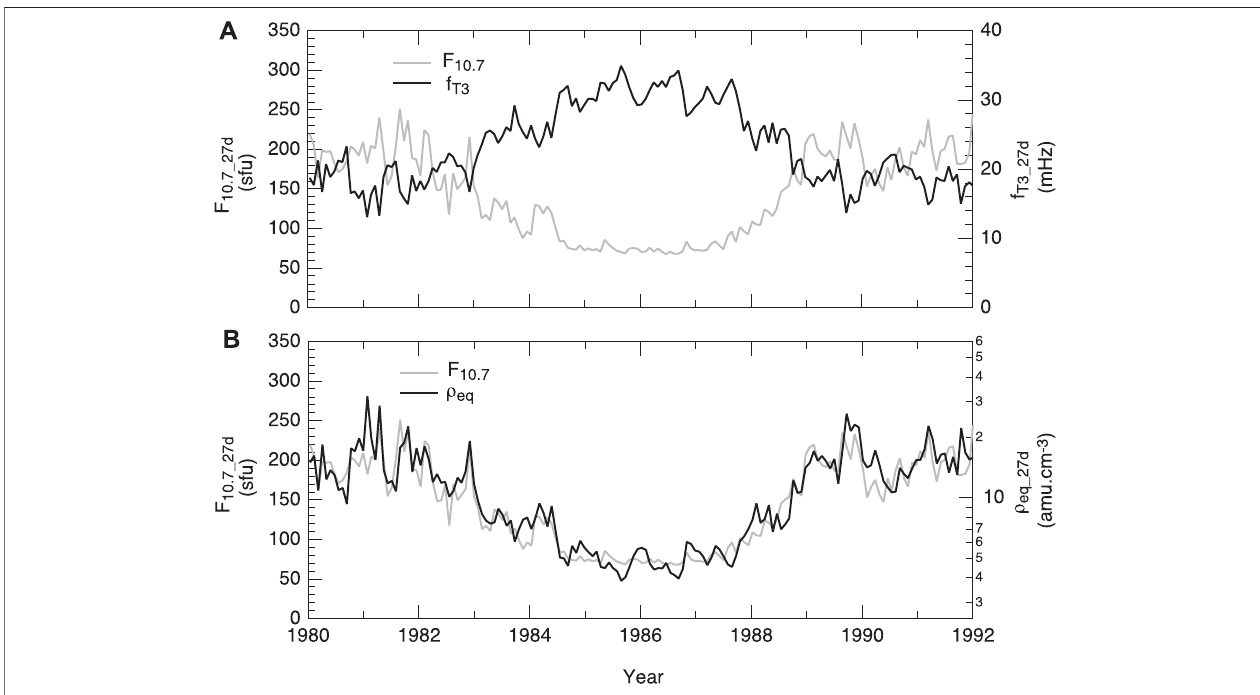
FIGURE6| ResultsofamagnetoseismicstudyusingGOESmagnetometerdata(afterTakahashietal.,2010). (A) Comparisonofthe F 10.7 indexandthefrequency of third harmonic toroidal waves at GOES over a solar cycle. The data are 27-day averages. (B) Comparison of the F 10.7 index and the mass density estimated from the wave